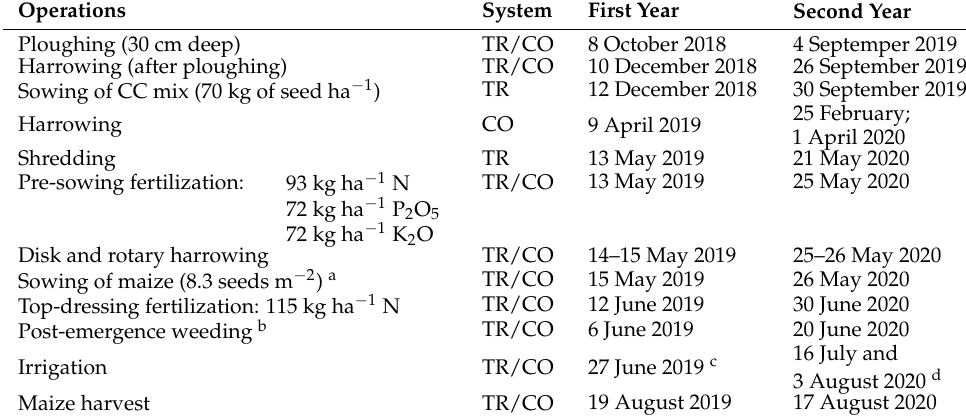
Table 1. Main cultivation practices for the treated (TR, with cover crops (CC)) and control (CO, without CC)